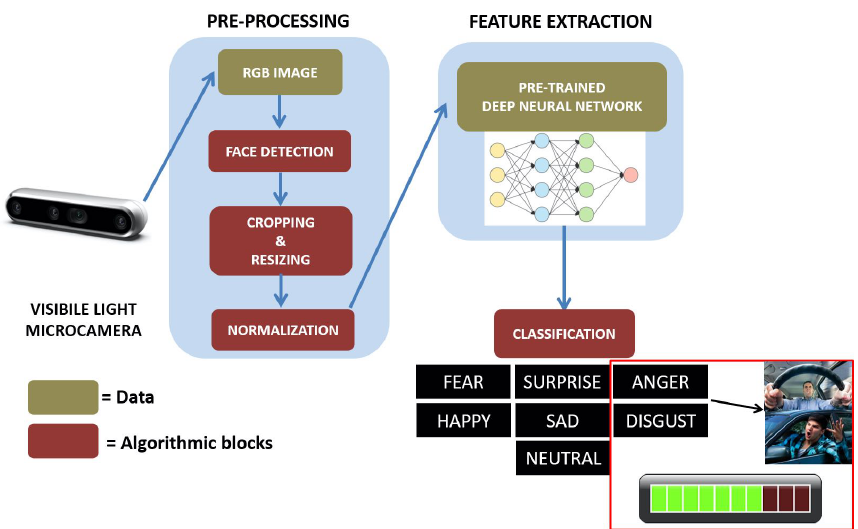
Figure 3. Overview of the proposed algorithmic pipeline designed and implemented for road rage detection in unconstrained